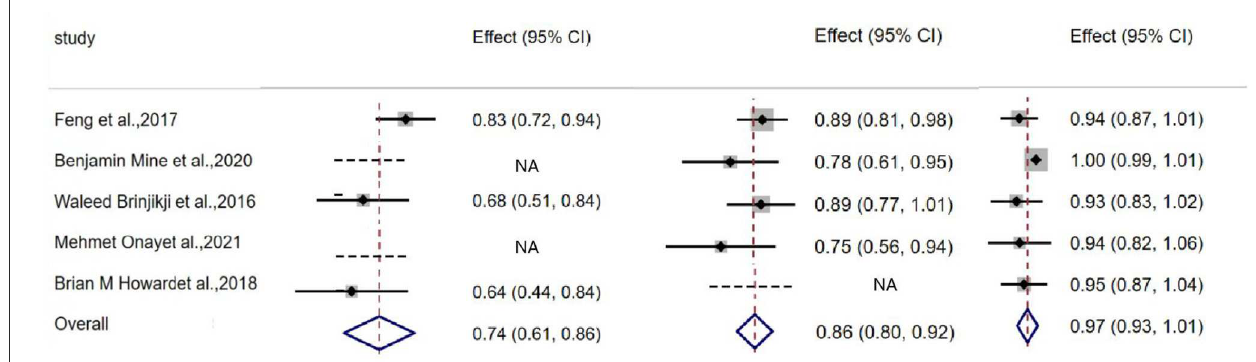
FIGURE3 Plot showing favorable clinical outcome after coiling, stenting and at follow